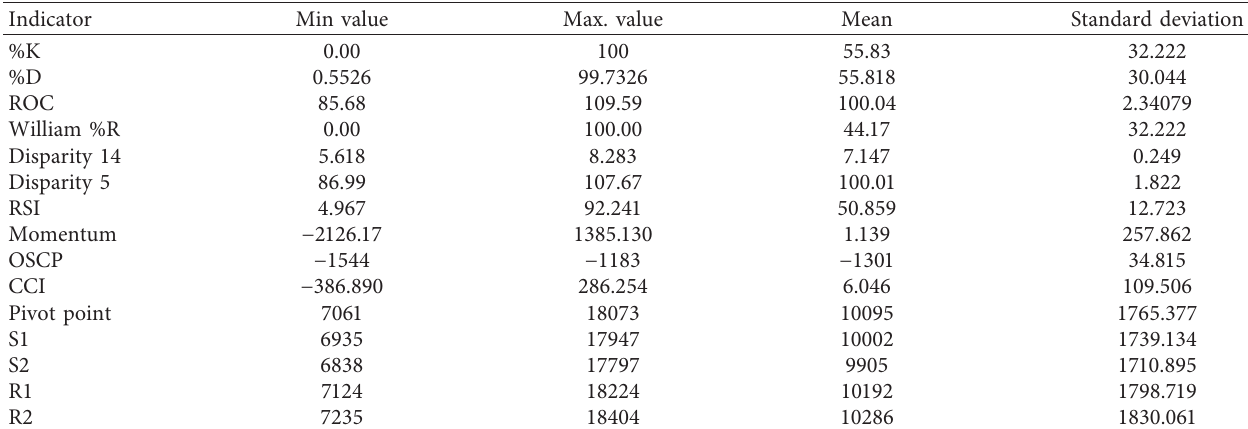
Table 5: Summary statistics of technical indicators for SZSE composite